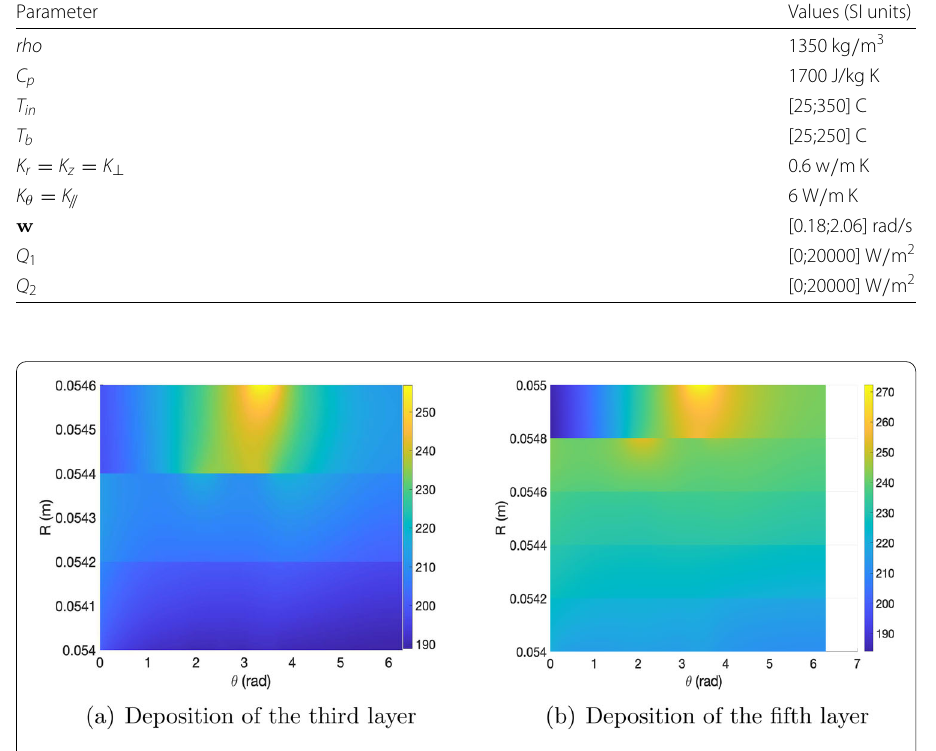
Fig. 5 Vertical section in the deposited layers during the deposition of the 3rd and 5th layers. Temperatures in ◦ C